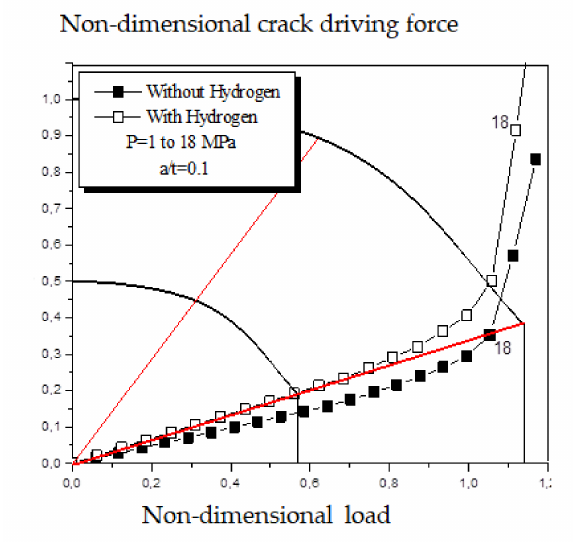
Figure 17. Loading path under or without HE. Pipe diameter D = 611 mm and thickness t = 11 mm, relative defect depth a/t = 0.1. Pipe from API 5L X52 steel and submitted to internal pressure p . The defect assessment (for a relative crack depth a/t = 0.1) is situated in the limit